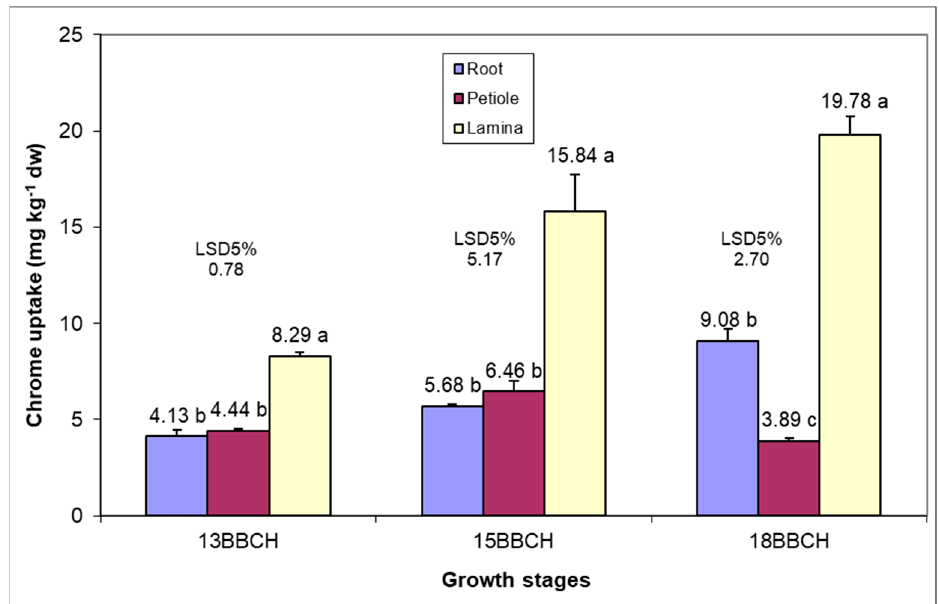
Figure 6. Cr uptake in S. perfoliatum organs for different development stages when grown in Ps. Error bars represent SE. Different letters (a–c) indicate significant differences ( p < 0.05) between plant